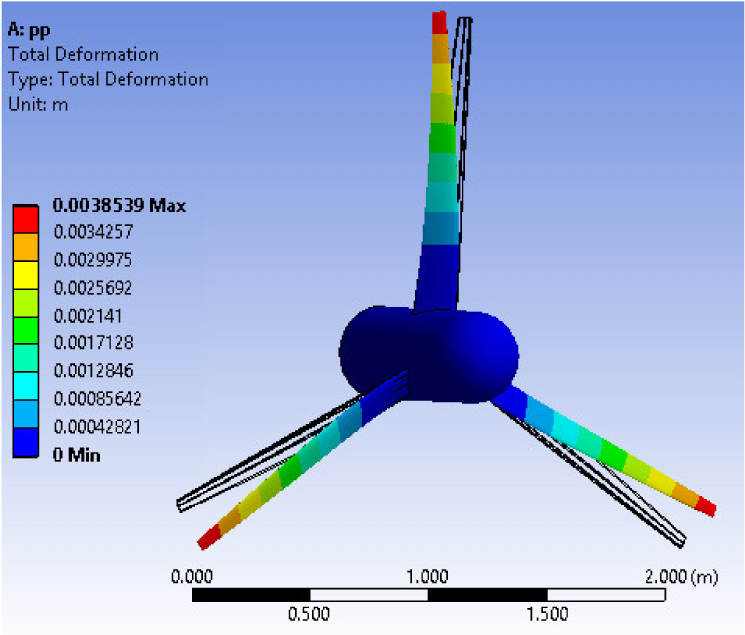
Figure 10. Graphical representation of maximum turbine blade deformation with PP material at TSR = 3.